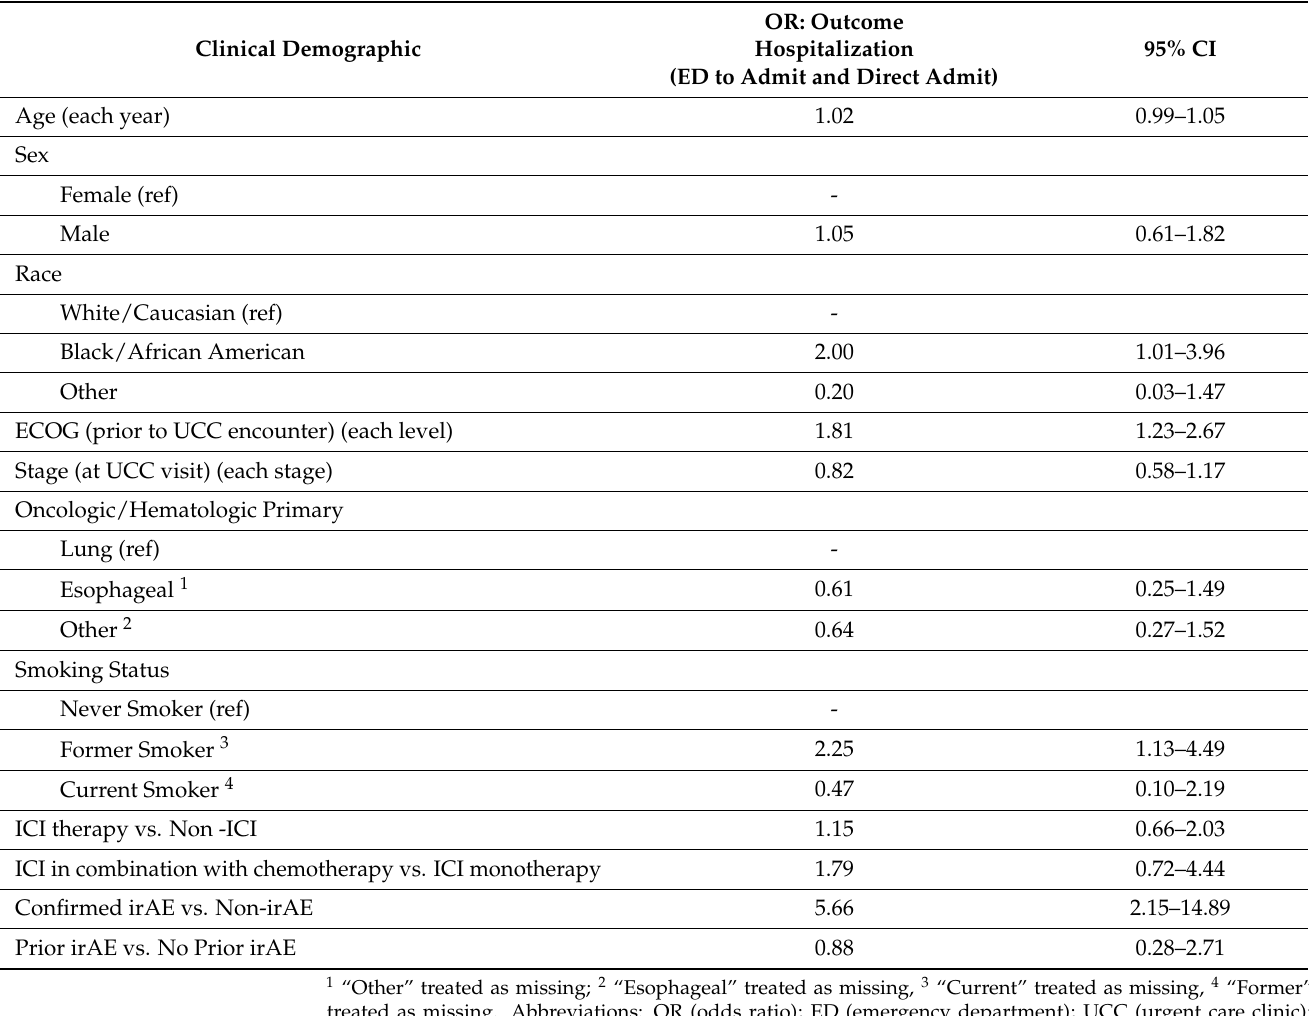
Table 2. Associations between clinical features and hospitalization following UCC encounters.